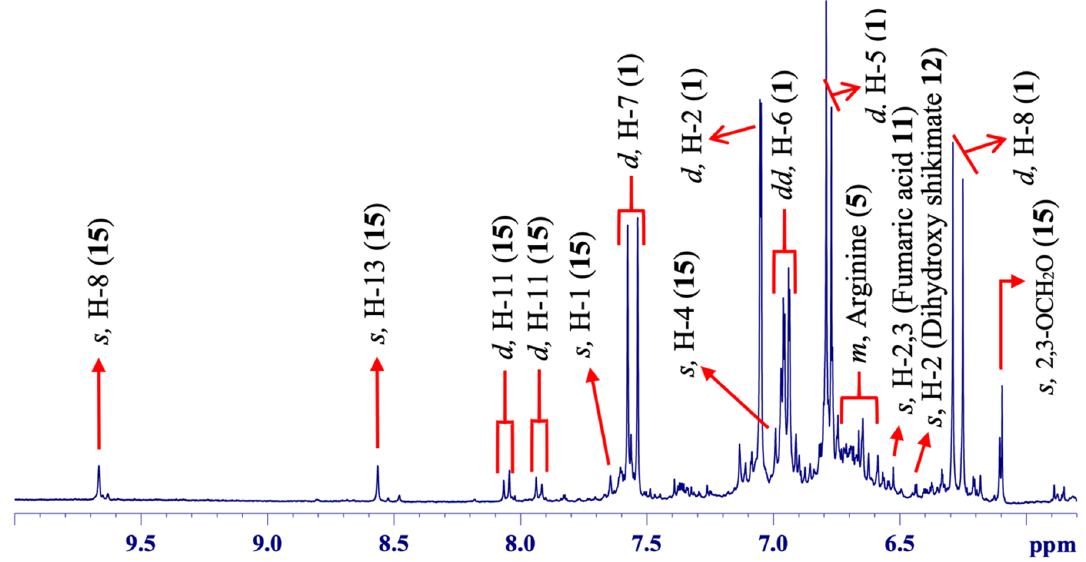
Figure 4. 1 H HR-MAS NMR ( ẟ 5.80–10.00) spectrum showing signal annotations from leaves of Berberis laurina (400 MHz, ~10 mg swollen in 40-µL CD 3